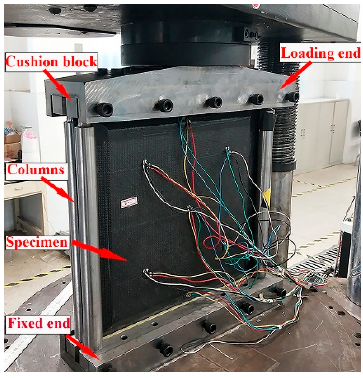
Figure 4. Fixture of tests.